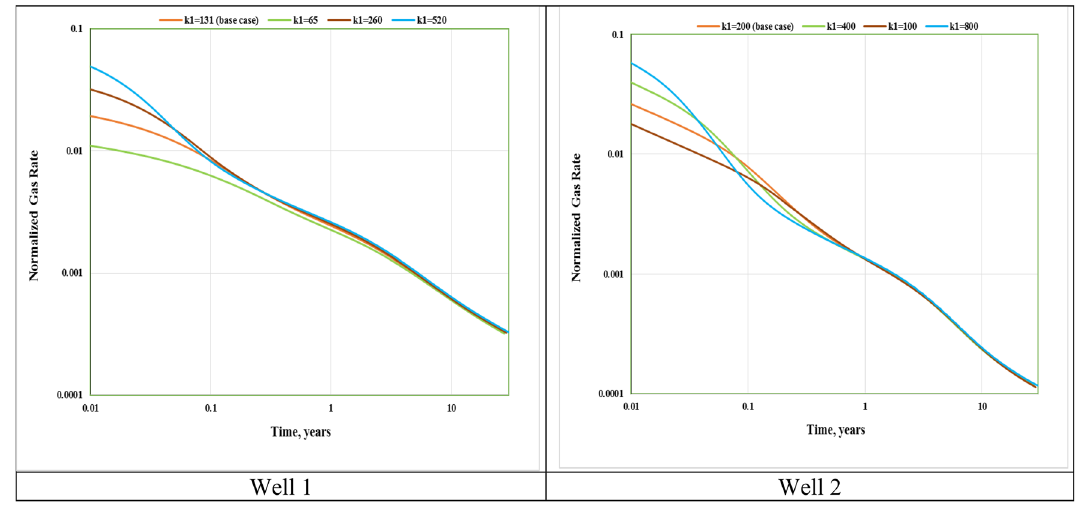
Fig. 14 Inner permeability sensitivity